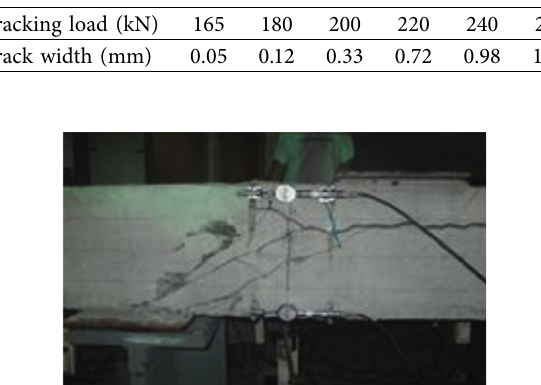
Figure 9: Final failure mode of the test plate by static load.